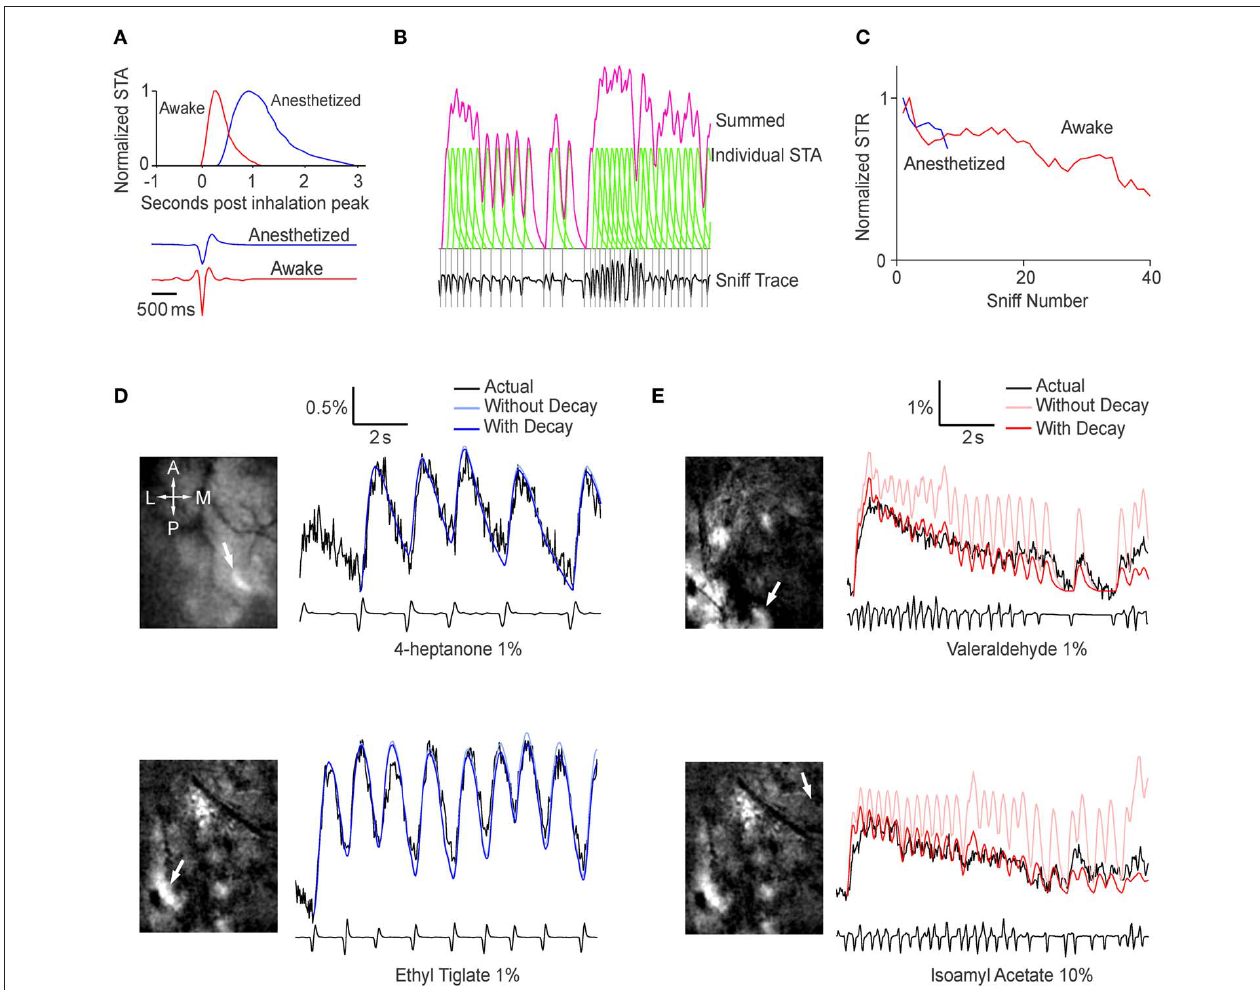
prediction time course (pink). (C) Sniff triggered response amplitude as function of sniff number. Values are relative to the amplitude of the first sniff-triggered response and normalized to the peak sniff-triggered average. These values were used as a lookup table adjust the sniff-triggered averages (D,E) . Examples of prediction time courses for anesthetized (D) and awake (E) animals. The images on the left are (cid:2) F projections with white arrows indicating the glomerulus used to derive the time